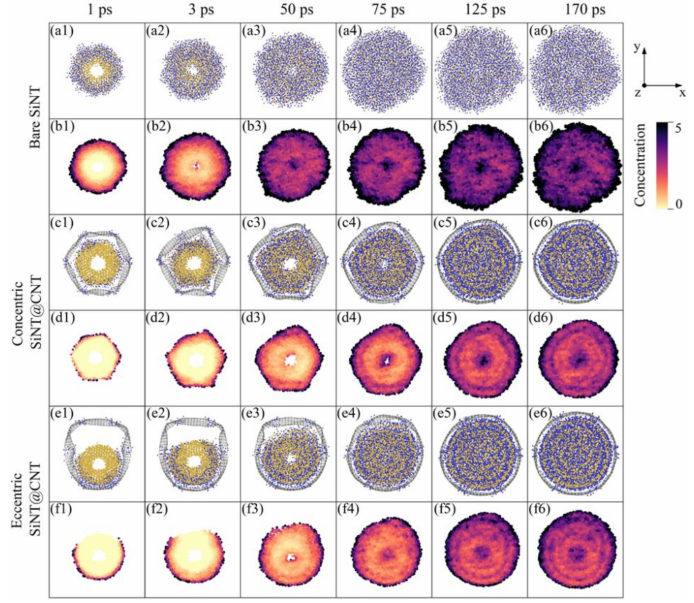
Figure 2. Morphological evolution. The cross-section snapshots for atomic structural evolution at a specific simulation time during the lithiation of ( a1 – a6 ) Bare SiNT, ( c1 – c6 ) Concentric SiNT@CNT, and ( e1 – e6 ) Eccentric SiNT@CNT. The lithium concentration maps at a corresponding simulation